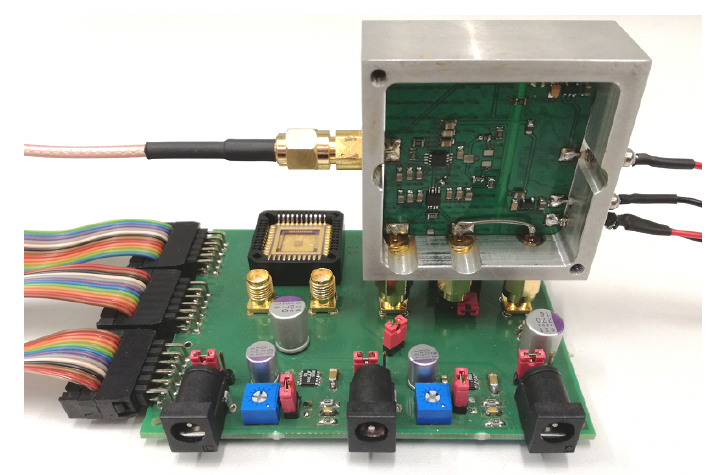
Figure 8: Custom measurement board carrying one of the 65 nm ASIC samples and the DC